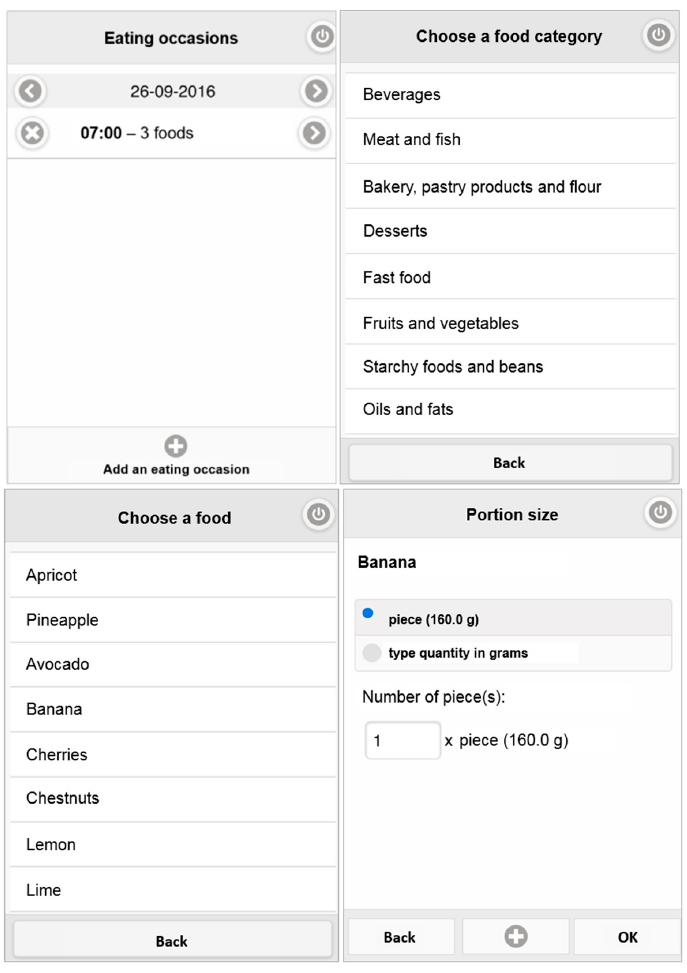
Figure 1. Illustration of the three steps for evaluating the electronic food record e-CA.